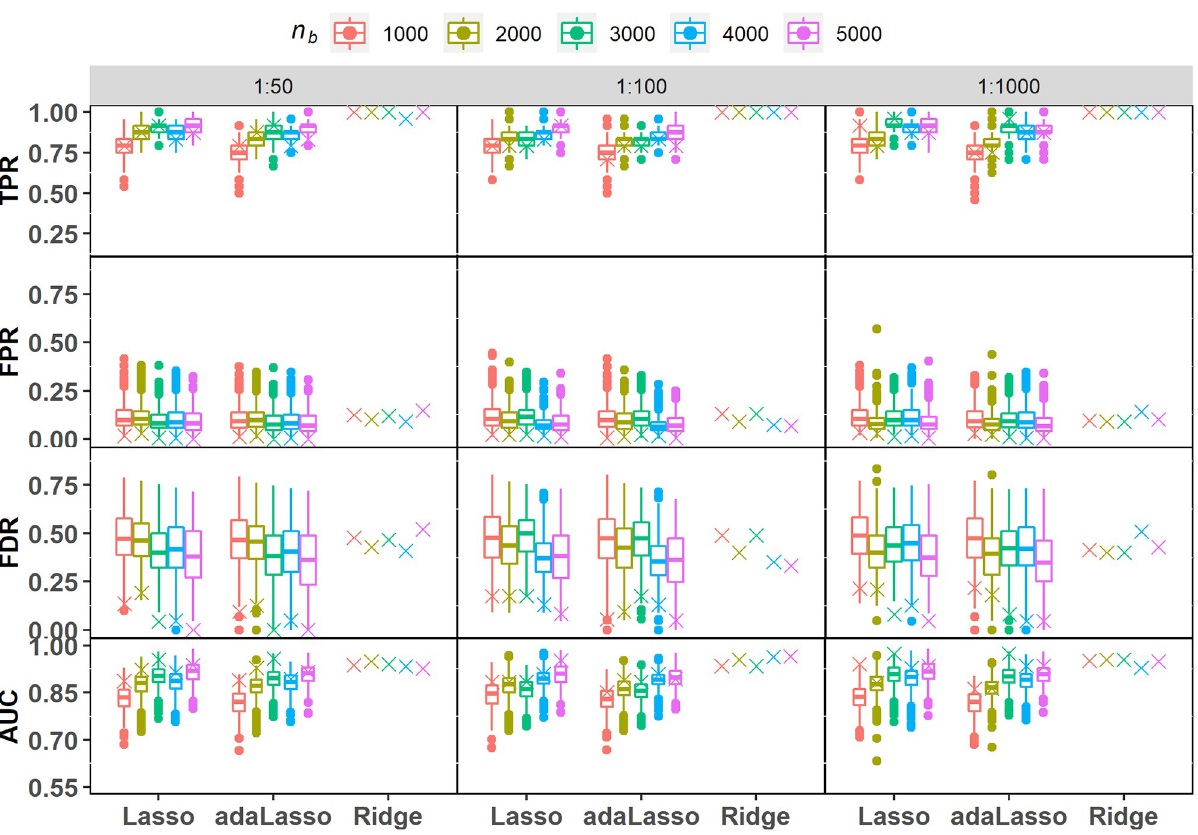
Fig 6. Simulation under COR-24. Performance metric scores for variable selection based on the SVRS algorithm (symbol x) and corresponding distributions across 500 individual fits of each regularization model with imbalance ratios 1:50, 1:100 and 1:1000. Performance scores for individual ridge regression fits are not applicable as it does not perform automatic variable